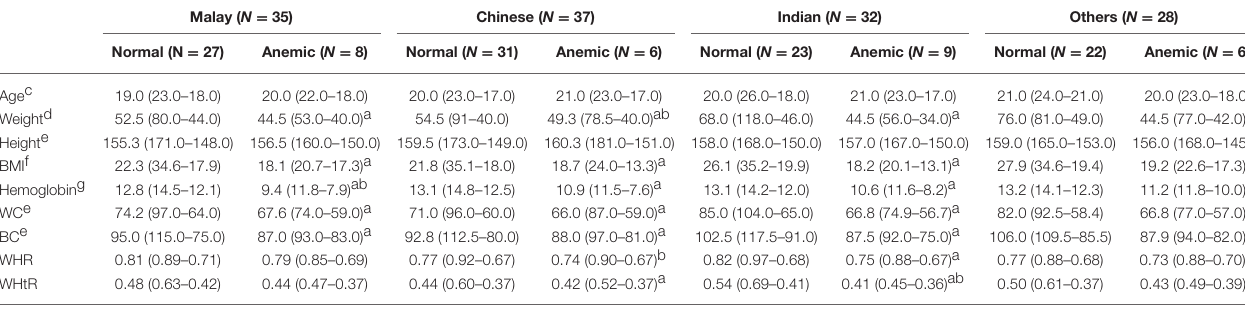
TABLE 6 | Comparison of various parameters among the women of different ethnic groups. Malay ( N = 35) Chinese ( N = 37) Indian ( N = 32) Others ( N = 28) Normal (N = 27) Anemic ( N = 8) Normal ( N = 31) Anemic ( N = 6)